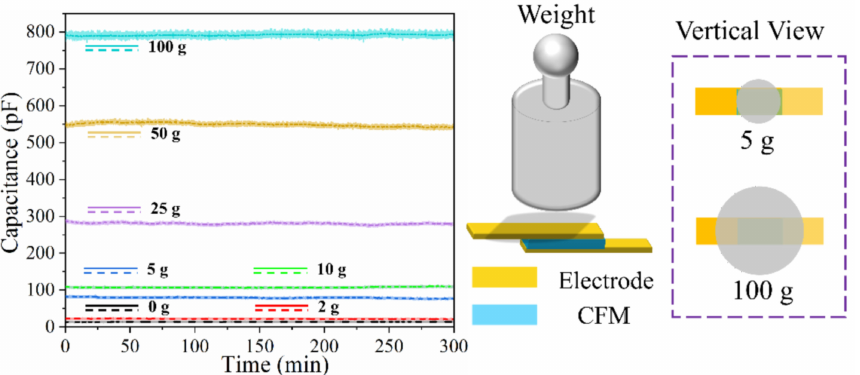
Figure 9. Long-term stability of pressure sensors to different